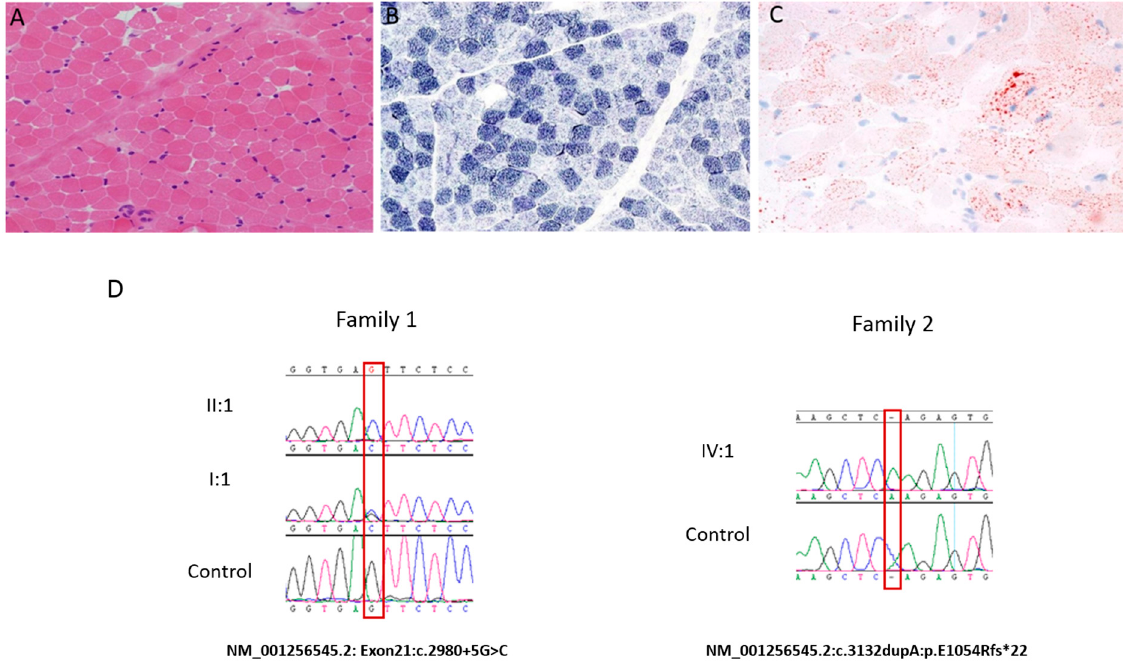
Figure 2. Histopathological and genetic findings. ( A ) H&E: Rare small fibers. ( B ) NADH: increased subsarcolemmal activity in some fibers. ( C ): Oil Red O stain: increase in intracellular lipid. ( D ) The image displays the chromatogram of the index patients (IV: 3 and II: 1 in each family) harboring the variants (c.3132dupA), (c.2980+5G>C), respectively.